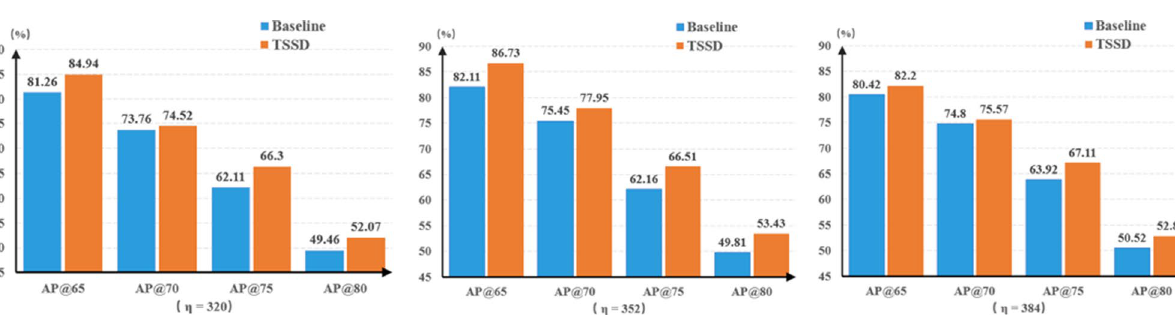
Figure 10. Comparison of accuracy between TSSD algorithm and the baseline model at different η